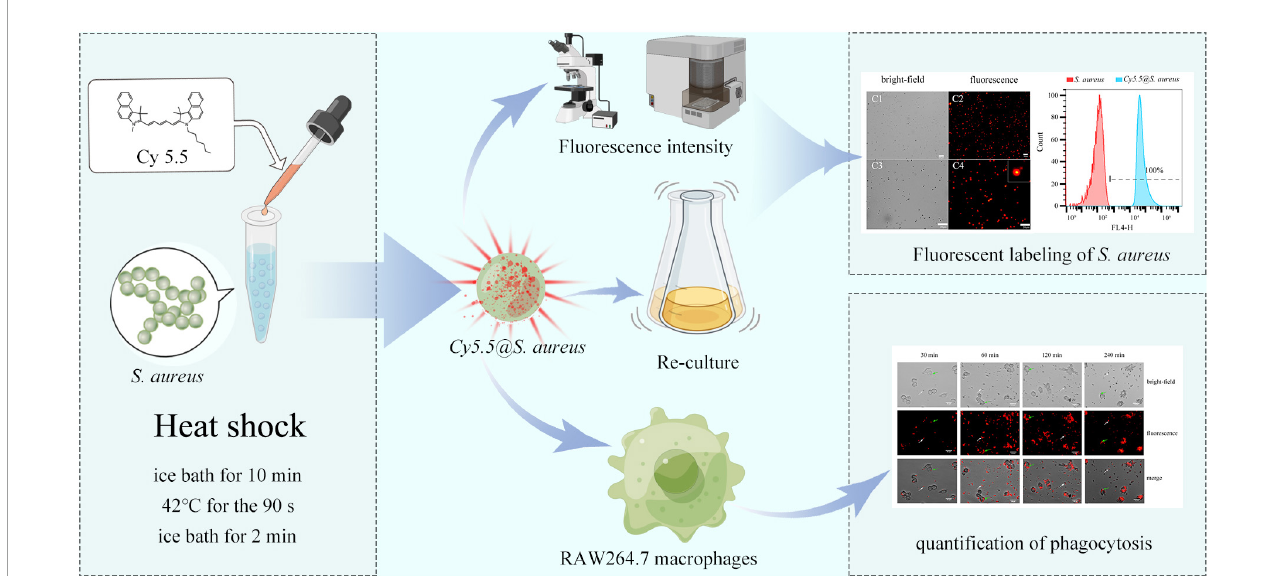
FIGURE1 Schematic to represent the experimental process used in this study. Intracellular labeling of Staphylococcus aureus is achieved by heat shock with Cy5.5. The cytotoxicity of Cy5.5 and the stability of Cy5.5@S. aureus was also evaluated by flow cytometry. Additionally, Cy5.5@S. aureus was used to explore the phagocytic behavior of RAW264.7